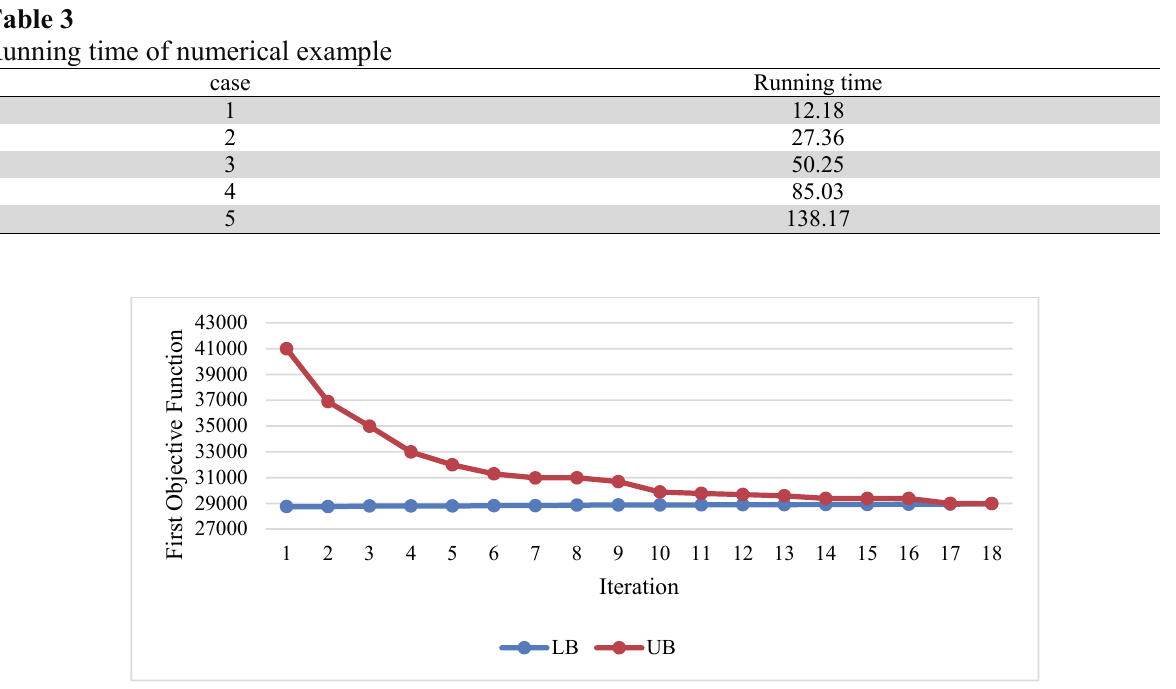
Fig. 1. Convergence diagram of allocation model for case No 4